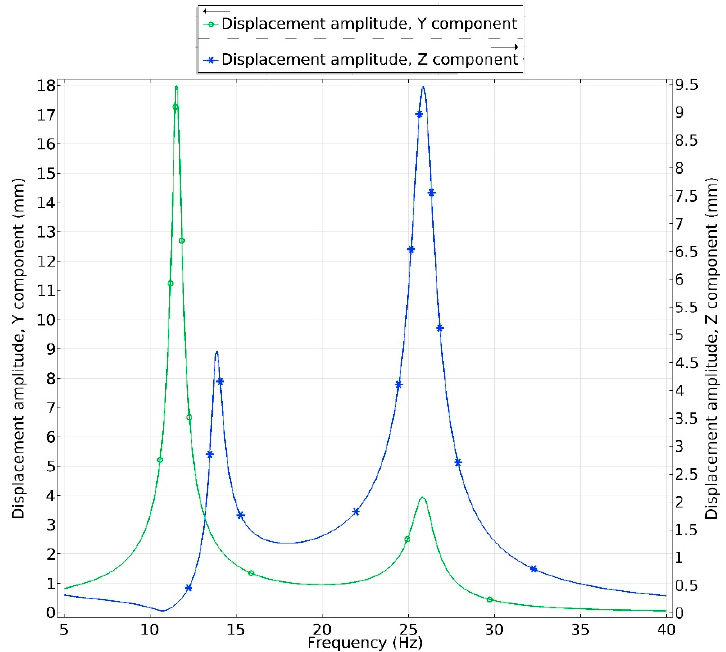
Figure 9. Displacement amplitude—frequency characteristics of bidirectional energy harvester.